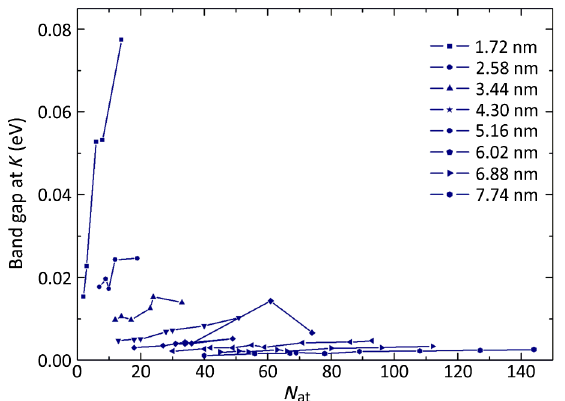
FIG. 6 (color online). Evolution of the energy gap between the two highest valence bands of CdSe sheets with graphenelike honeycomb geometry as a function of the number of atoms that form the nanocrystal-nanocrystal contact ( N nanocrystals is indicated by the body diagonal of the truncated